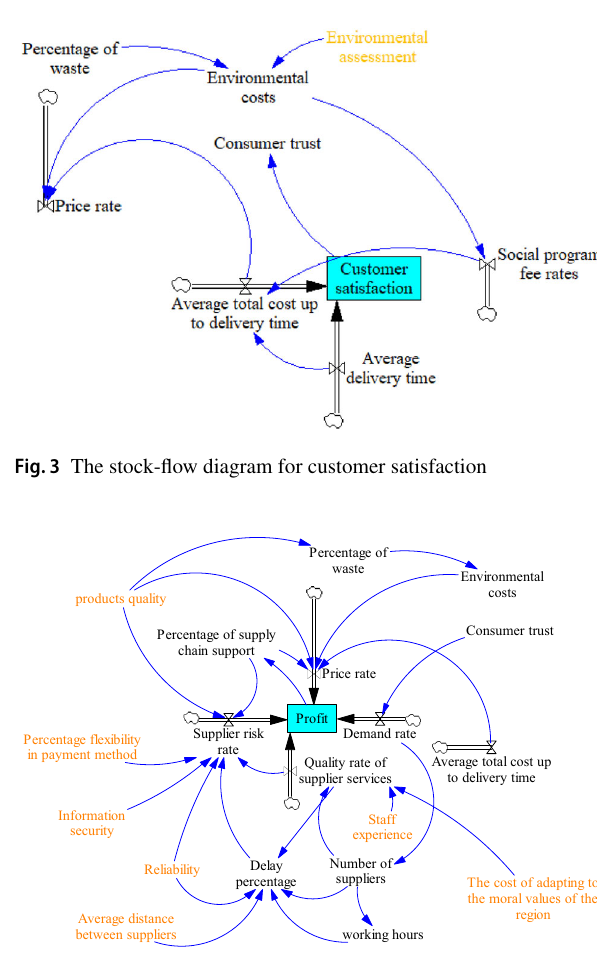
Fig. 4 The stock-flow diagram for profitability the lower the ancillary costs, such as after-sales services and returned goods, which reduce the risk of cooperation with the